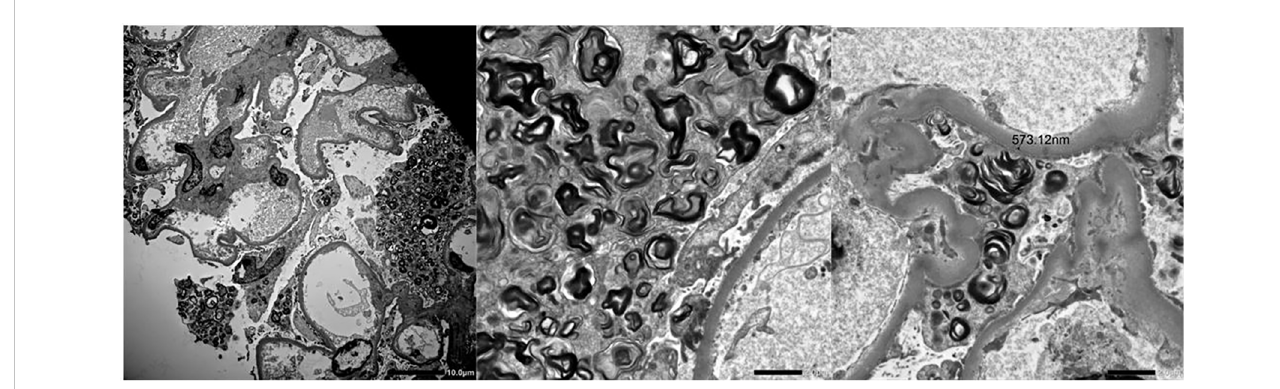
FIGURE 3 Electron microscopy showing Zebra Bodies in a patient who received a diagnosis of Fabry disease.